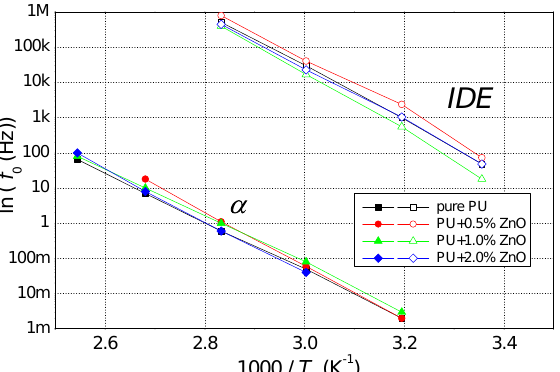
Figure 7. The dependence of ln( f 0 ) of pure PU and their various nanocomposites as a function of (1/ T ), obtained from experimental